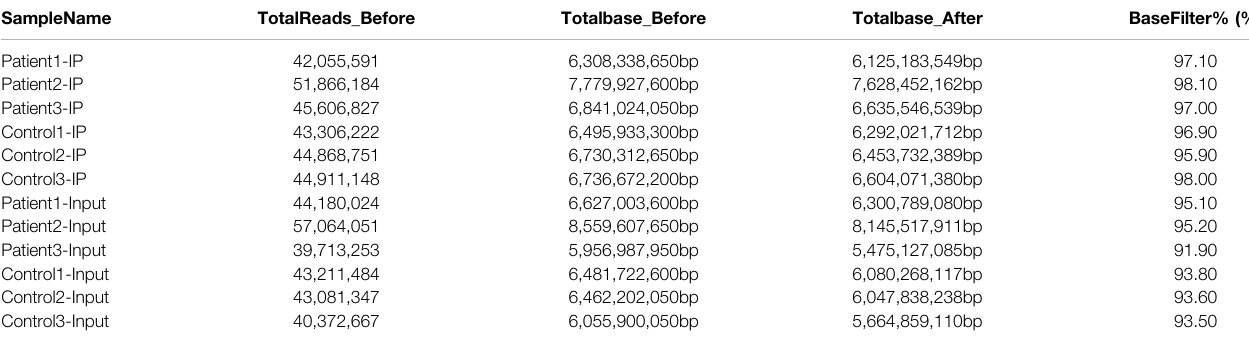
TABLE 2 | Summary of reads quality control analysis.